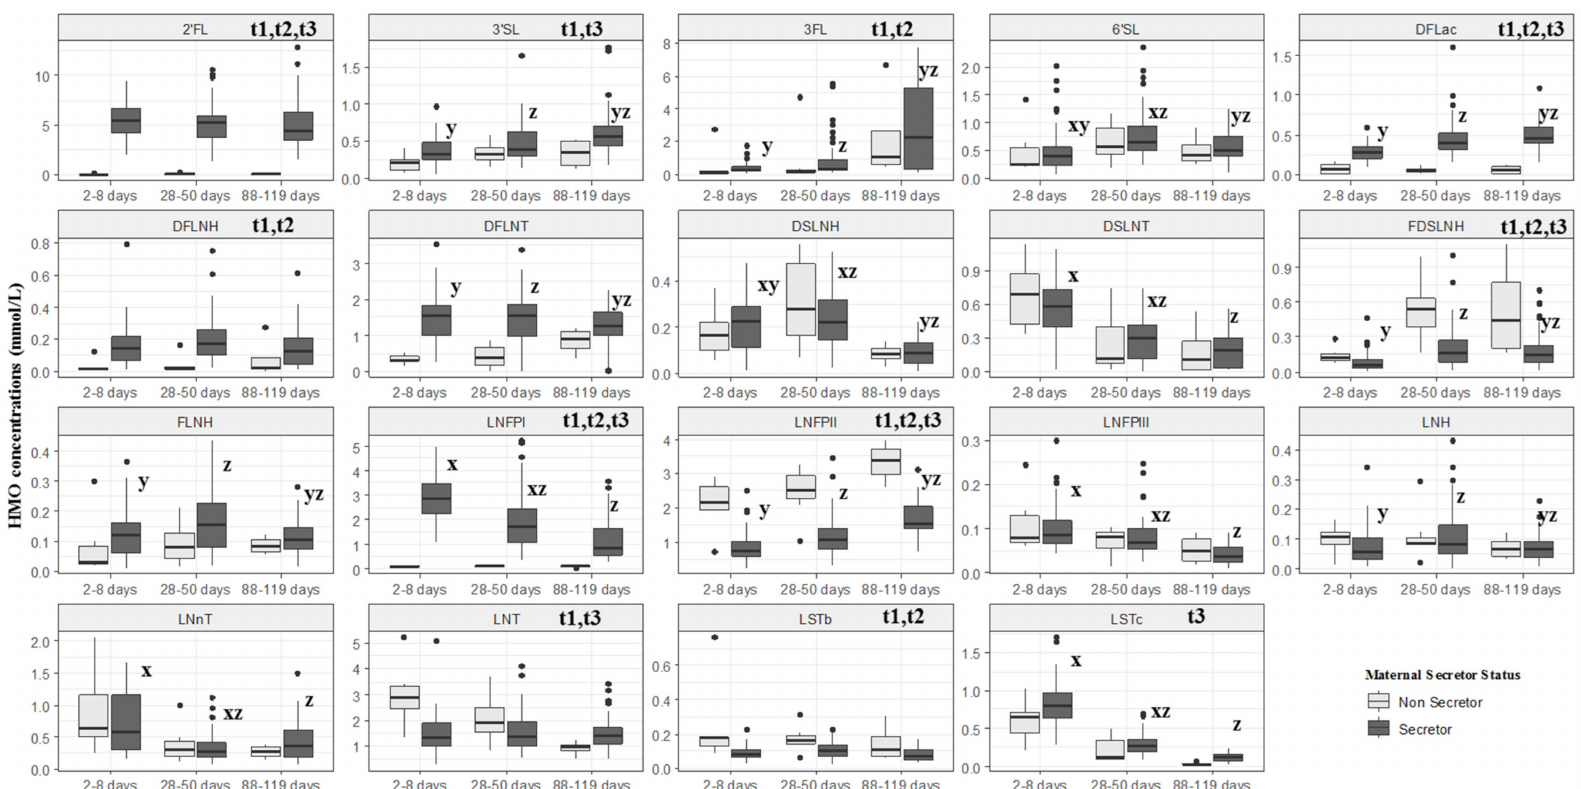
Figure 3. Box plot of secretor and non-secretor HMOs concentration of women from Brazilian cohort. Rio de Janeiro, Brazil. The description t1, t2 and t3 indicate di ff erences between secretor and non-secretor concentration of according to Mann–Whitney, p < 0.05 for each time. x indicates that the HMO concentration at visit 1 is significantly di ff erent ( p < 0.05) from the concentration at visit 2, y indicates that the HMO concentration at visit 1 is significantly di ff erent ( p < 0.05) from the concentration at visit 3 and z indicates that the HMO concentration at visit 2 is significantly di ff erent ( p < 0.05) from the concentration at visit 3 according to Friedman post-hoc test. A comparison between the times of non-secretor women was not